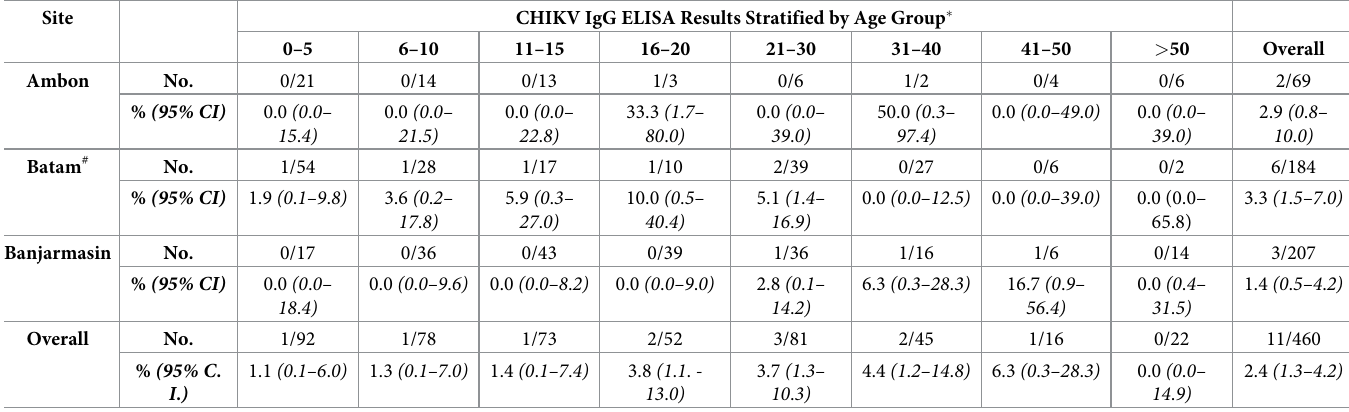
Table 2. Age specific IgG seroprevalence rates for chikungunya virus in three Indonesian cities.